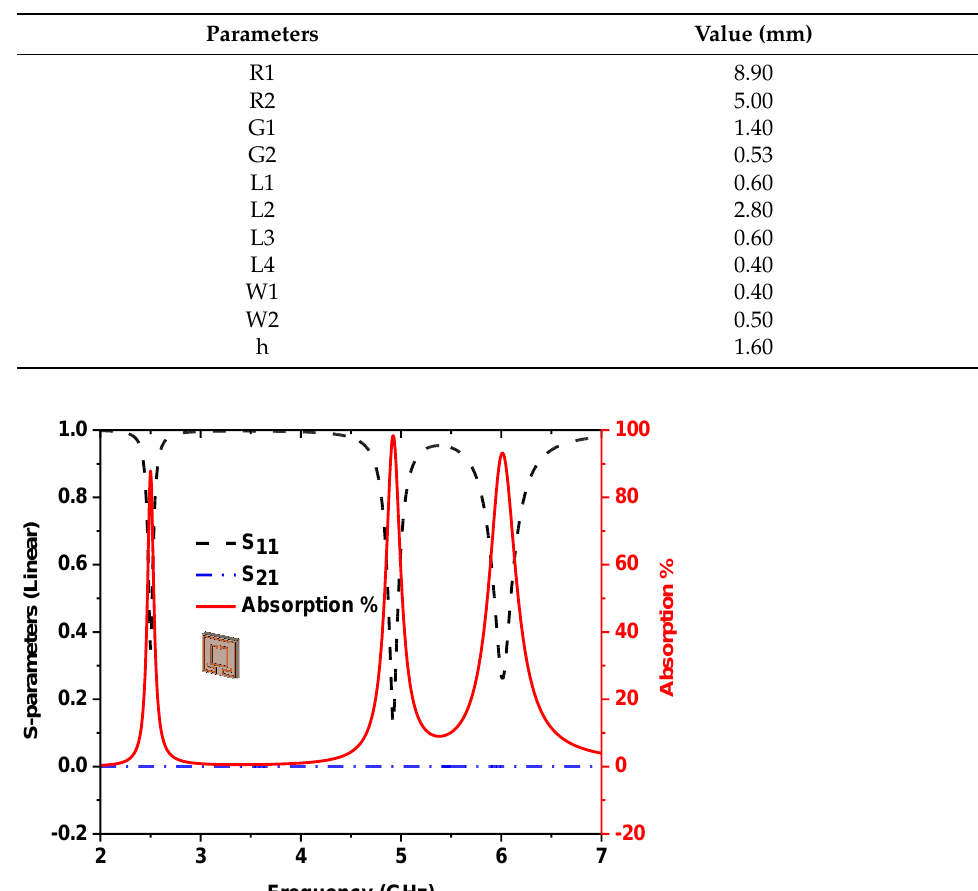
Figure 1. ( a ) Perspective view and ( b ) Simulation setup of proposed MMA. Table 1. Parameter’s list of proposed MMA.